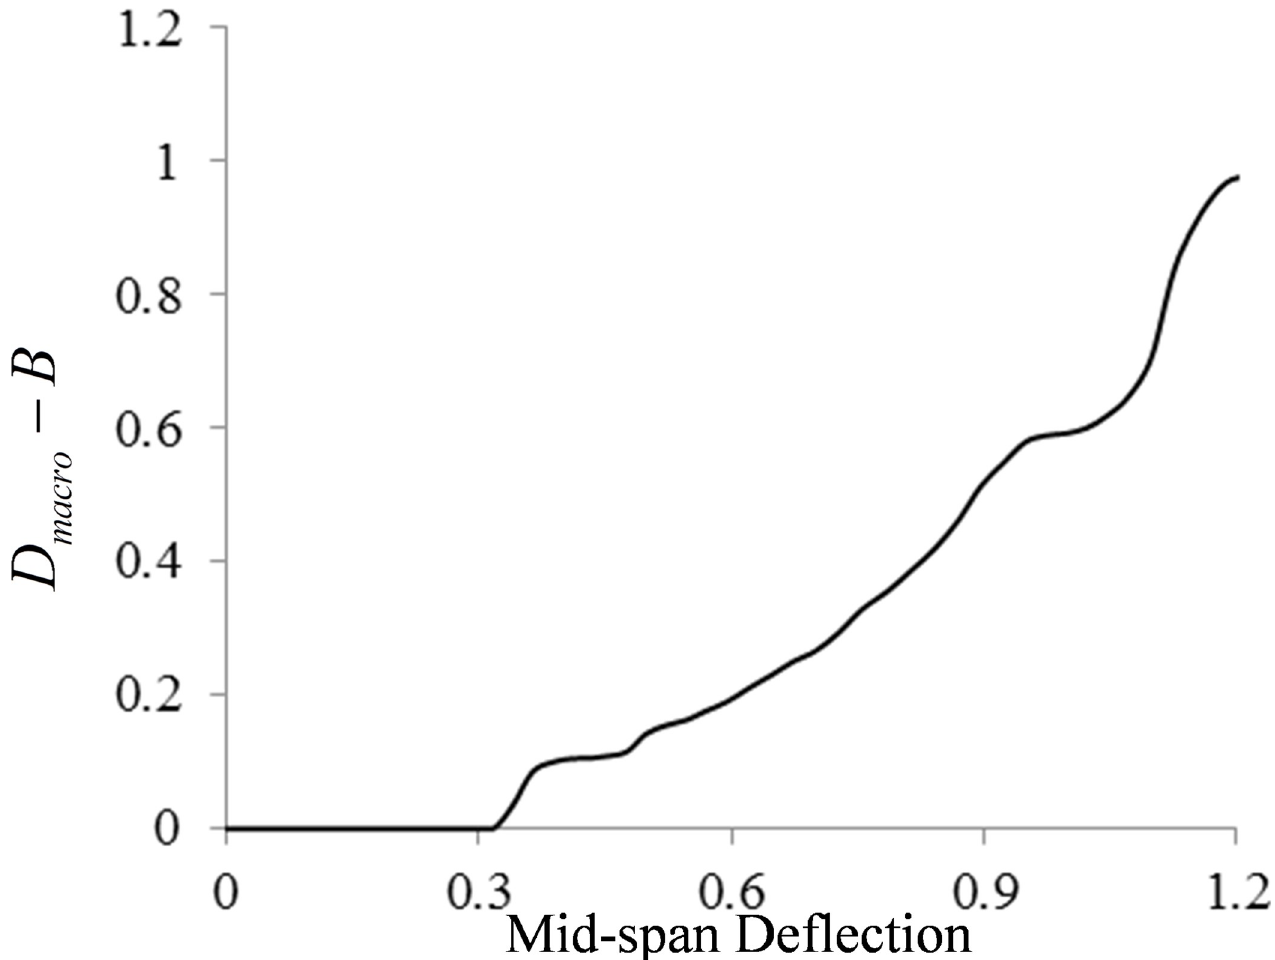
Fig 18. The relationship of macro damage and mid-span deflection in the four-point bending beam. D mac variable of the beam, and its calculation method is as shown in Eq (8).